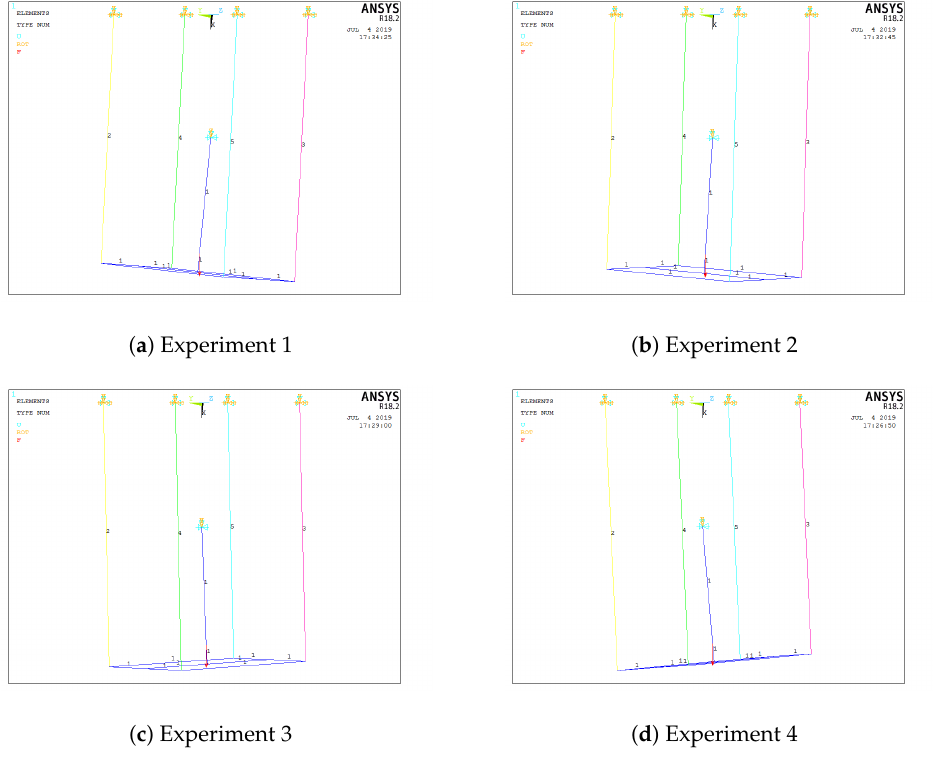
Figure 9. Geometric configurations analyzed.